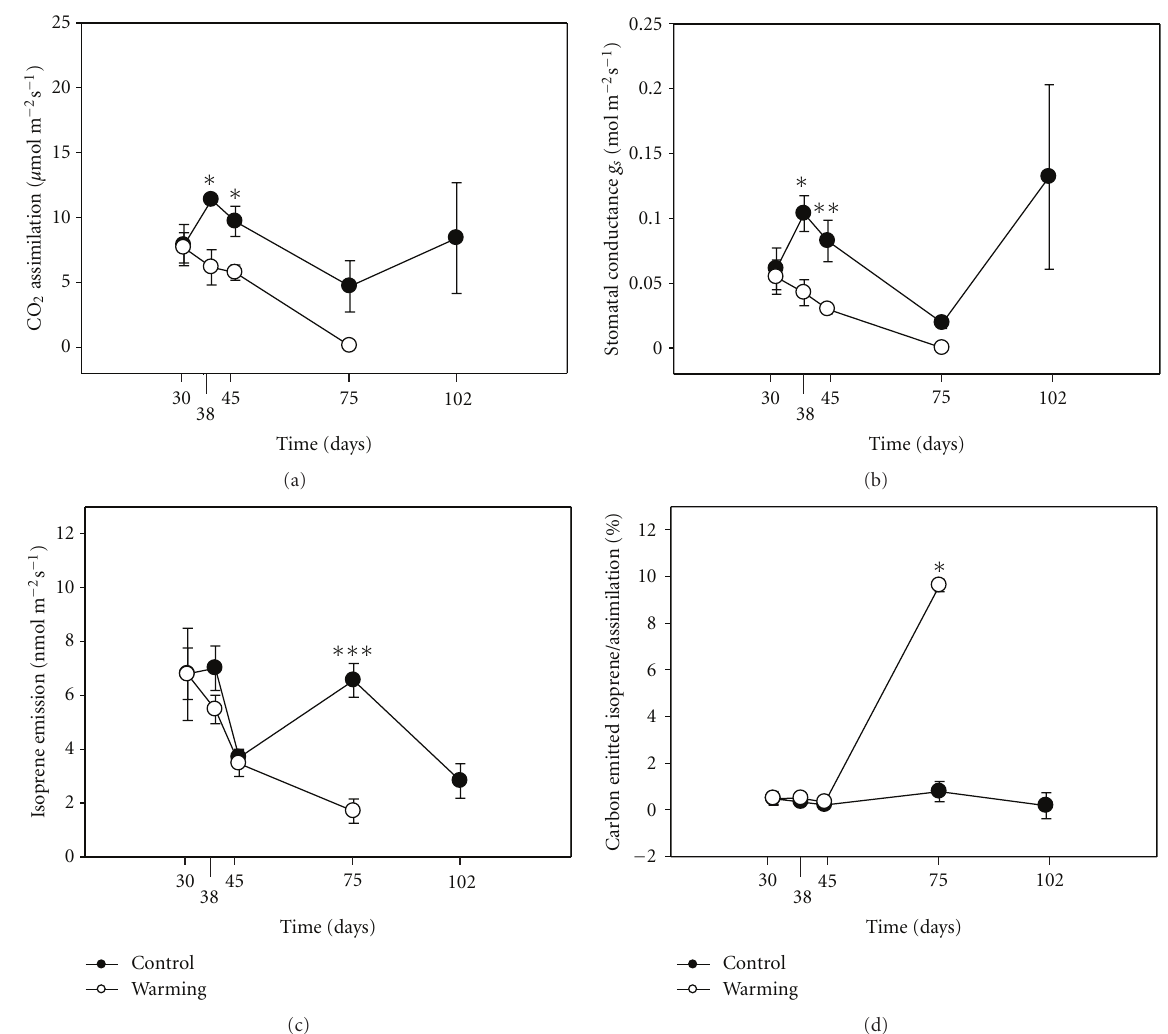
Figure 3: Time course of (a) CO 2 Assimilation ( μ molm − 2 s − 1 ), (b) Stomatal conductance (molm − 2 s − 1 ), (c) Isoprene emission (nmolm − 2 s − 1 ), (d) percentage of assimilated carbon lost as isoprene (%), ± S.E. for Populus x euramericana grown in a hydroponic system with water at di ff erent temperatures at 30, 38, 45, 75, and 102 days after start of treatment. ∗ P ≤ 0 . 05, ∗∗ P ≤ 0 . 01, ∗∗∗ P ≤ 0 . 001. Measurements started after 30 days from the beginning of the warming treatment, that is, as soon as the first mature leaves were